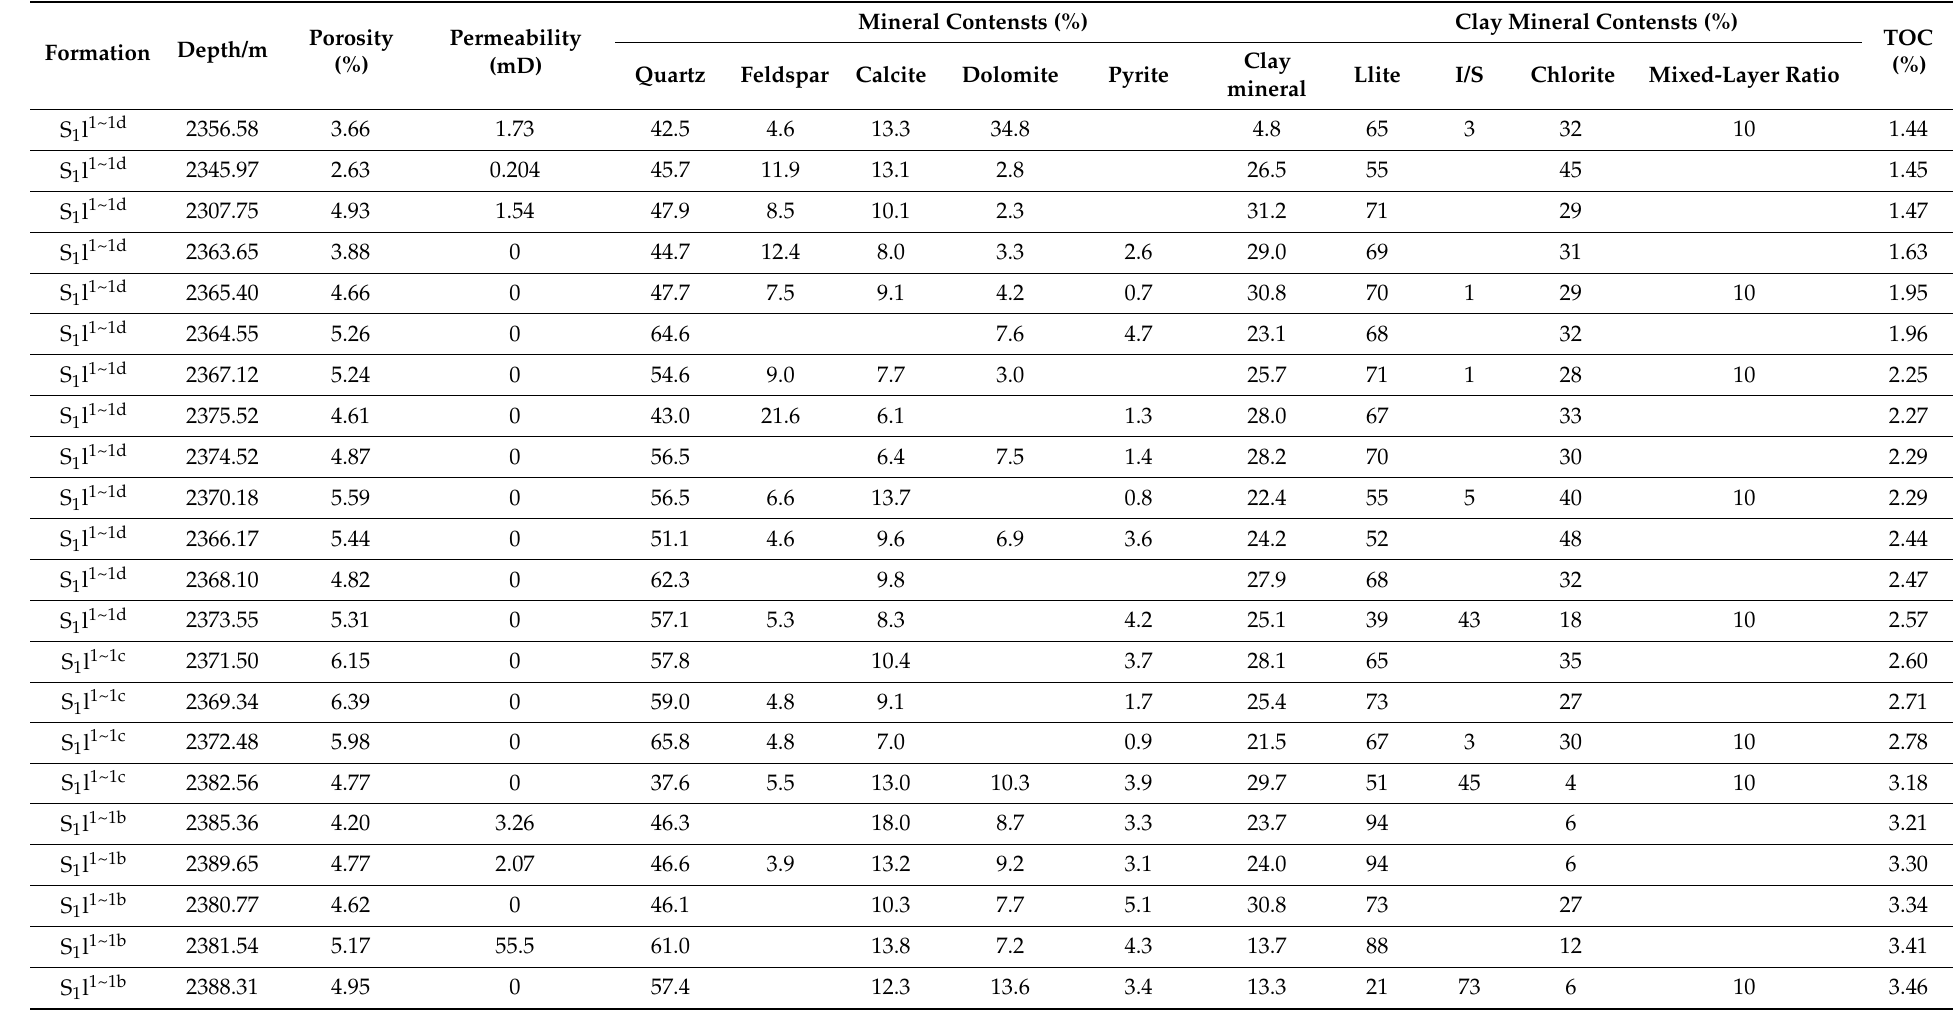
Table 1. Physical property, mineralogical compositions and TOC content of shale of S 1 l 1 − 1